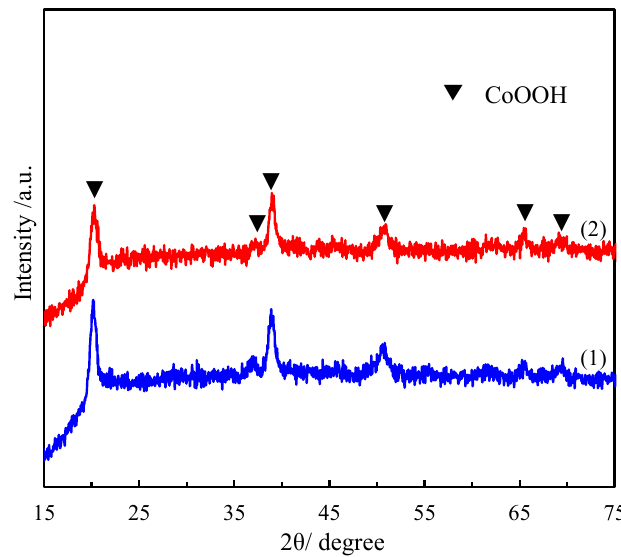
Figure 1. XRD patterns of (1) pure CoOOH and (2) CoOOH/rGO.